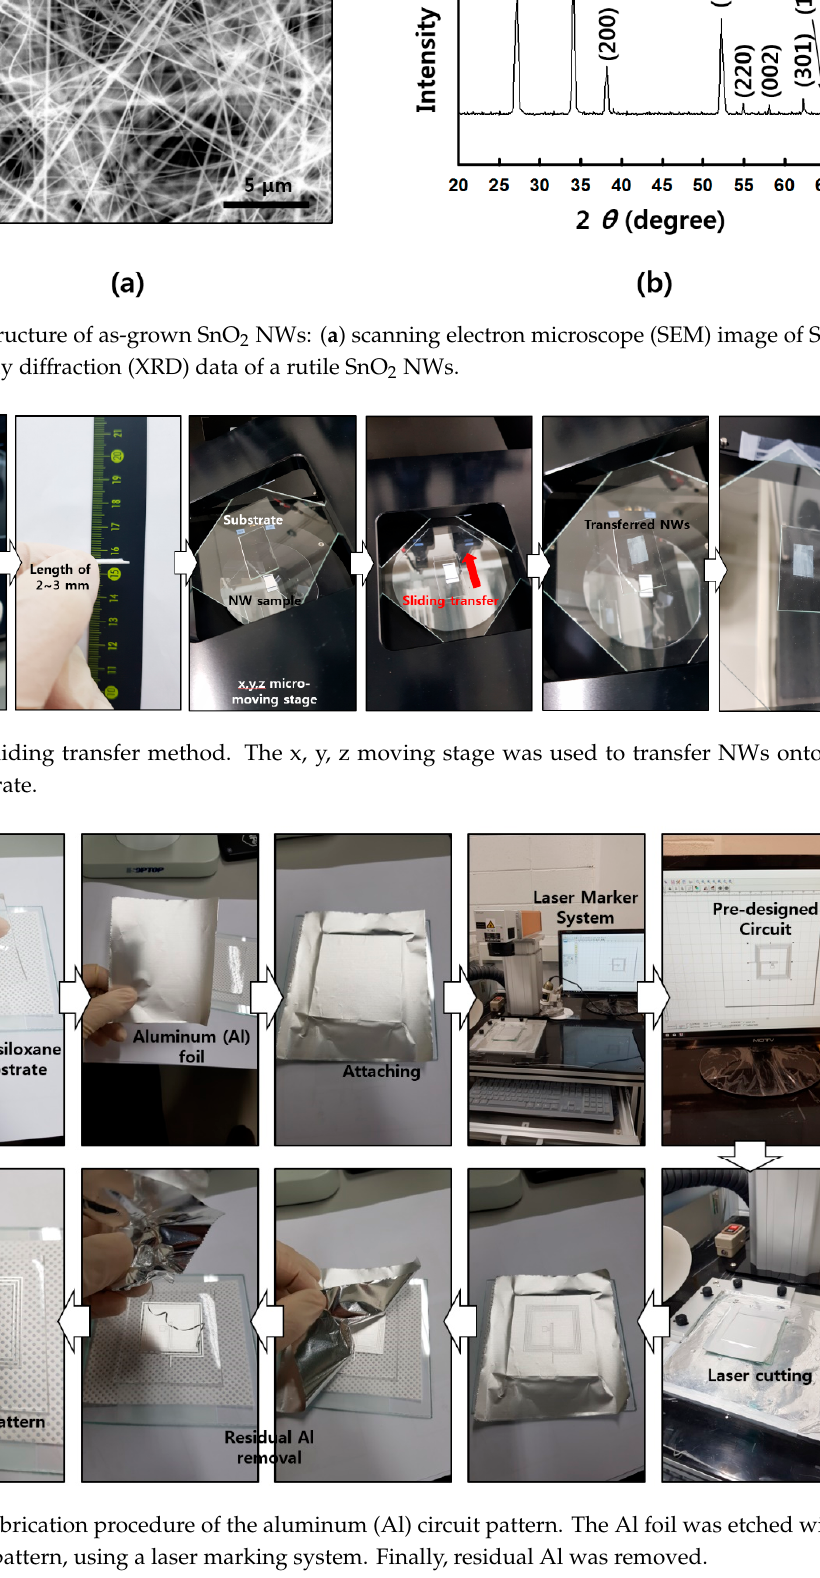
Figure A5 . Microscopic images of chip integration and Al connection. A fine tweezer, sharp needle, and soldering gun with a sharp tip were used to connect the circuit.